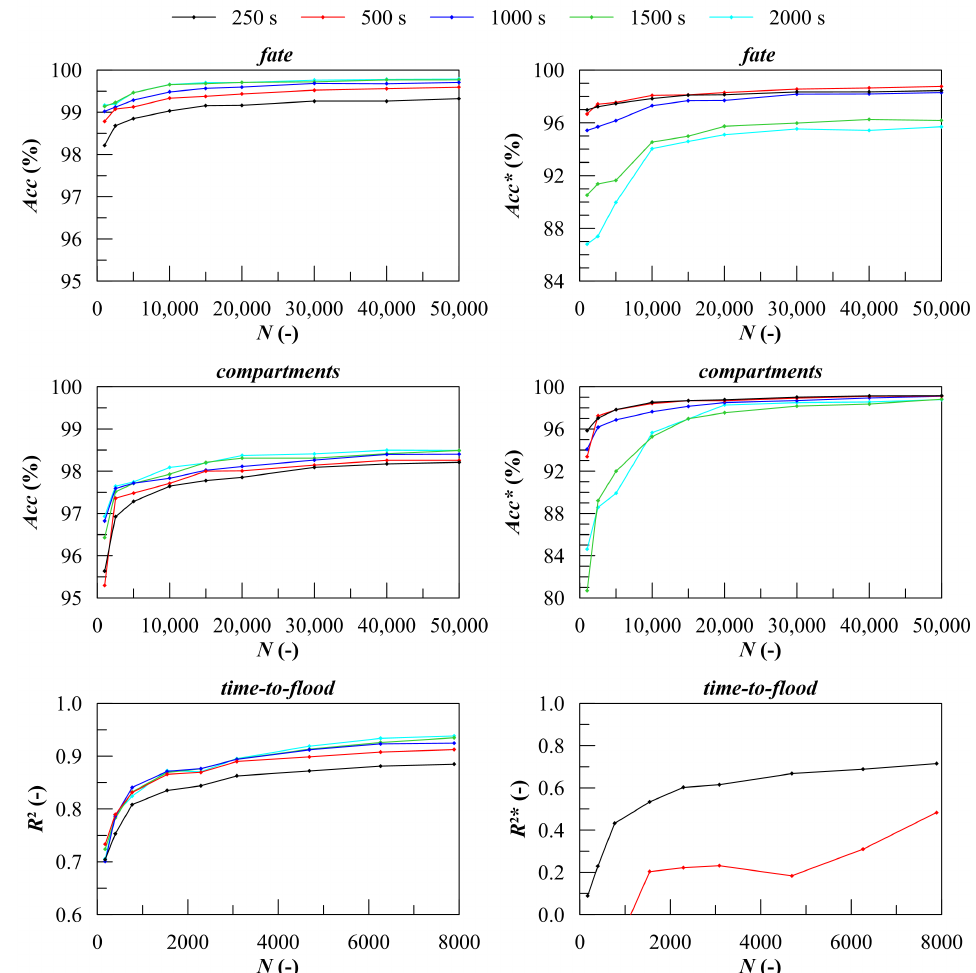
Figure 9. Accuracy evaluated at different time instant as function of number of damage cases in the training database employing Bagged Decision Trees (DTB) classification technique. Validation: